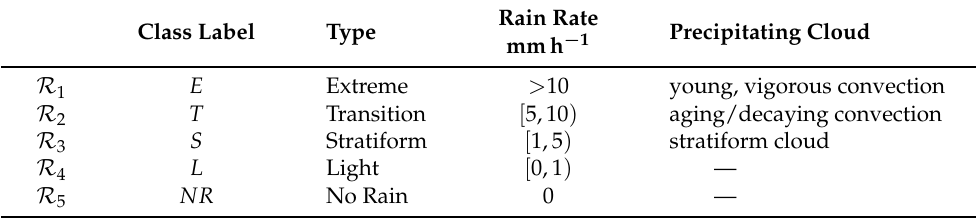
Table 3. Rain classes ( R = { E , T , S , L , NR } ) and thresholds.